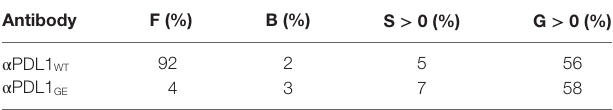
TaBle 1 | N-glycan analysis of the anti-PD-L1 variants α PDL1 WT and α PDL1 GE antibody